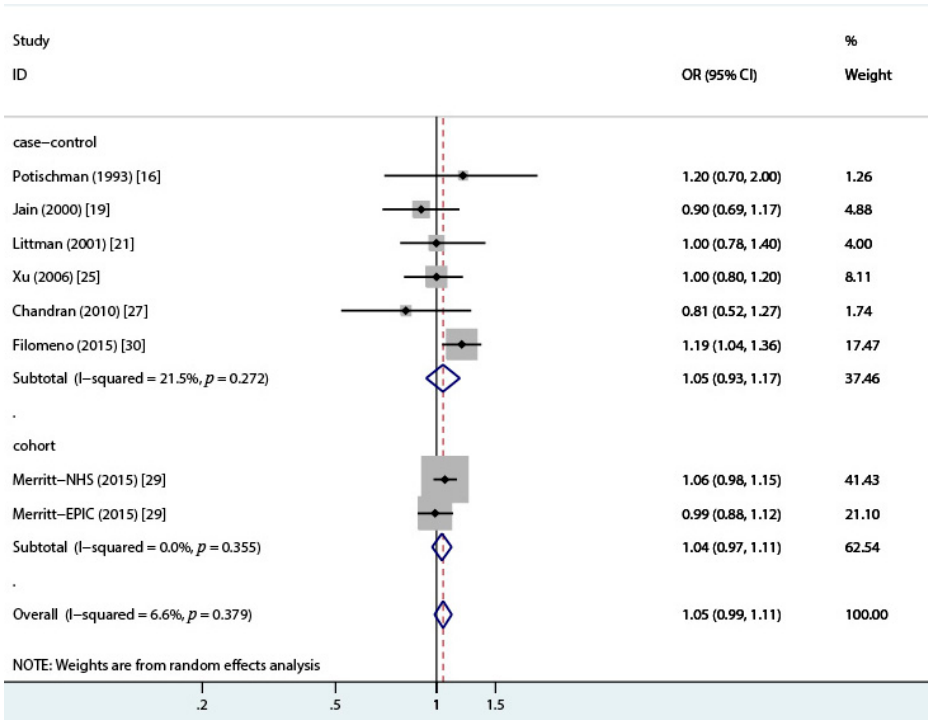
Figure 5. Forest plot of the summary risk estimate of endometrial cancer in the highest category of total dairy intake compared with that in the lowest category after exclusion of Newcastle—Ottawa Quality assessment scale (NOS) scores less than 6 by the random effects model. OR, odds ratio; CI, confidence interval.